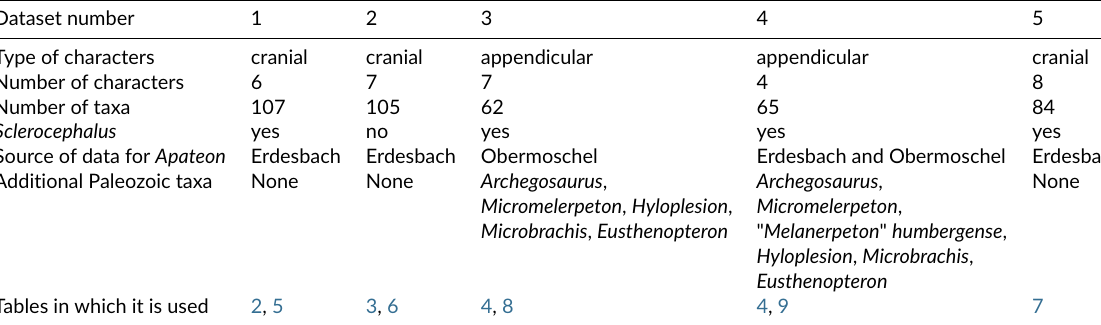
Table 1 – List of datasets used in this paper. All are subsets of our global compilation that were selected to meet the requirement of the method used (missing data cannot be handled). The temnospondyl species Apateon caducus and A. pedestris are included in all datasets, but scored after populations from two different paleo-lakes in which both species